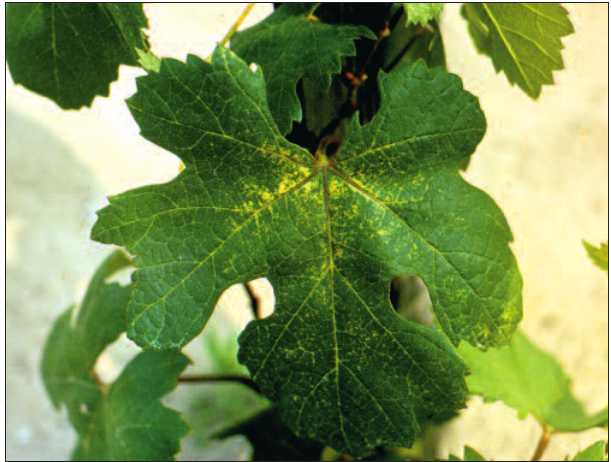
Figure6 . Tomato black ring (TBRV) – chlorotic spots, rings and lines on the leaves